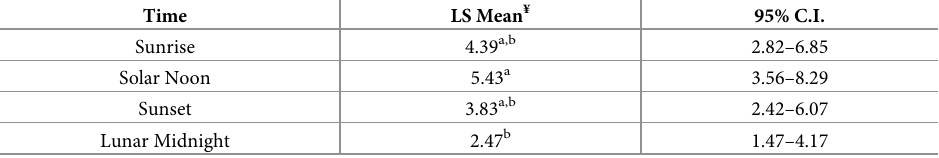
Table 2. Least square mean estimates from log linear analysis of Florida human sweep net counts of all Aedes albopictus for six sites over four time periods: Sunrise, Solar Noon, Sunset, and Lunar Midnight. Time